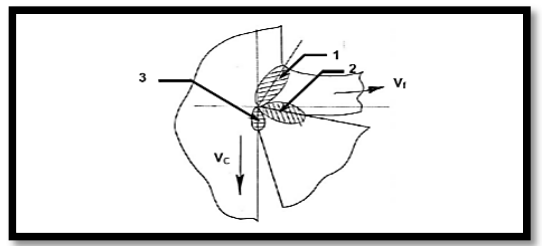
Fig. 1. Sources of heat in metal cutting